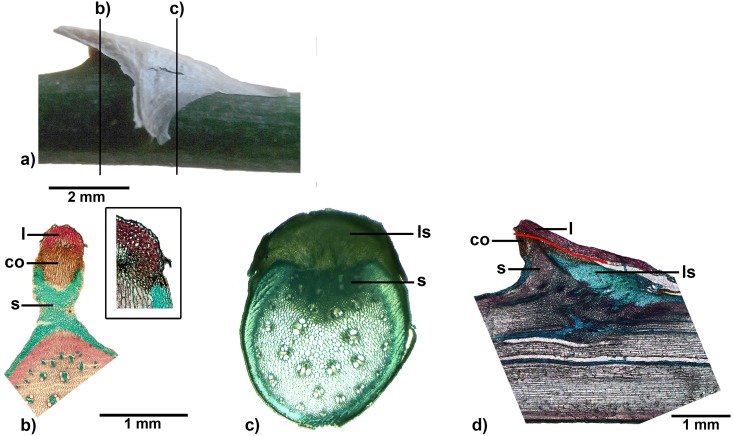
Spine of Asparagus setaceus.a) Side-view of a spine, lines indicate section planes of cross sections b) and c), b) and c) cross sections at different planes (from different specimens), b) stained with FCA, c) stained with toluidine blue (box: close up from a different cut), d) longitudinal section stained with toluidine blue. l: leaf tissue, s: stem tissue, ls: lateral shoot tissue, co: cork layer.